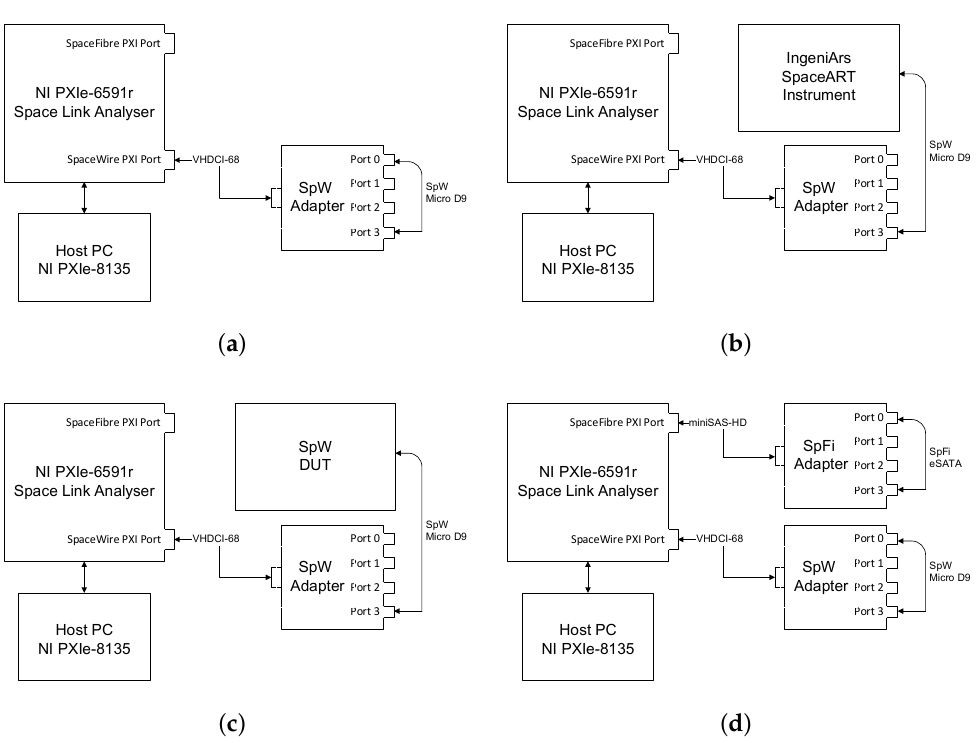
Figure 6. Various setups of the tests carried out. From top to bottom and left to right: ( a ) loop-back configuration, ( b ) SpaceART (IngeniArs) test configuration, ( c ) SpaceWire DUT test configuration, and ( d ) SpaceFibre test